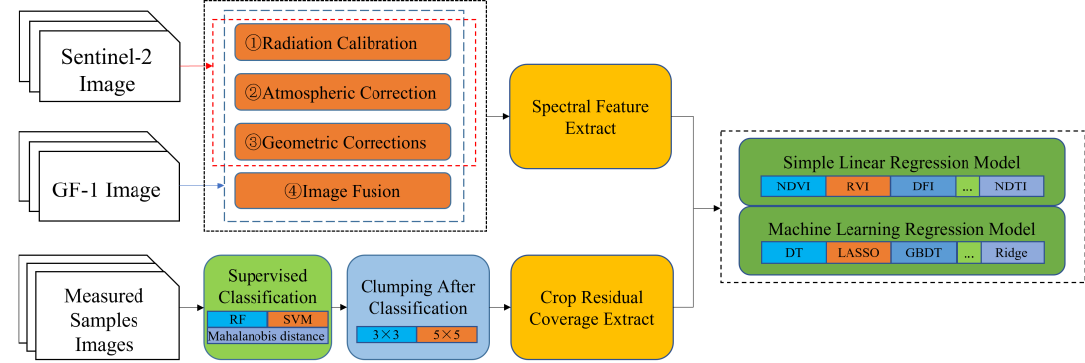
Figure 3. Overall technical route of the experiment.